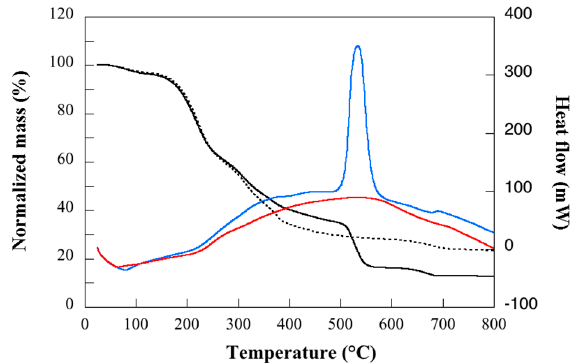
Figure 4. Mass and heat flow as a function of temperature. Black solid and broken curves refer to mass in air and nitrogen, respectively, and blue and red curves refer to heat flow in air and nitrogen. Exothermal heat flow is shown in positive numbers.